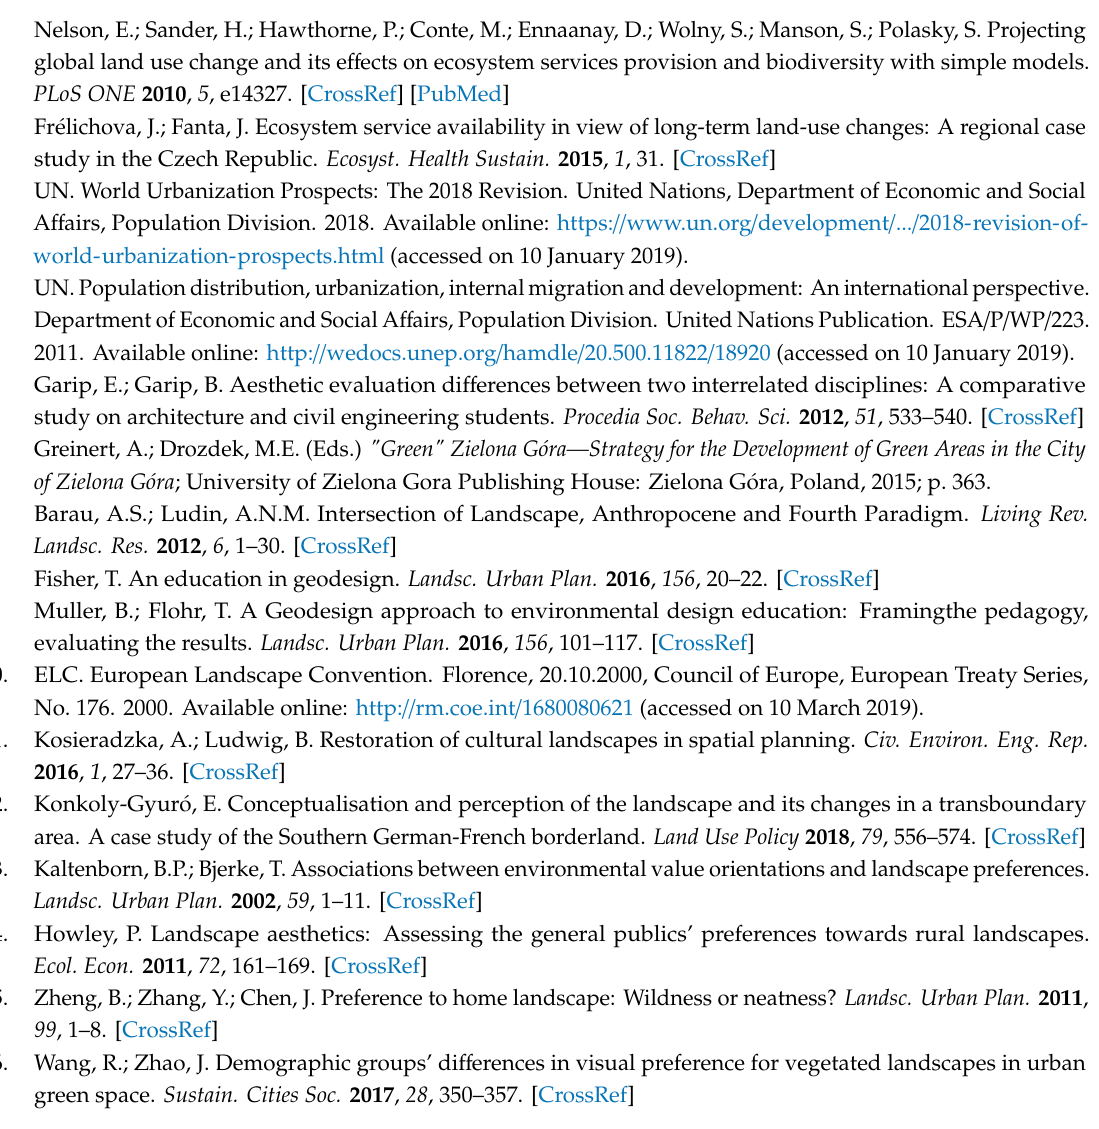
Figure S1: Characteristics determining the perception of the place of residence (EnvEng and CivEng students combined, n = 244), Table S1: Share of responses of students regarding their relationship to the place of residence, in % (EnvEng and CivEng students combined, n =